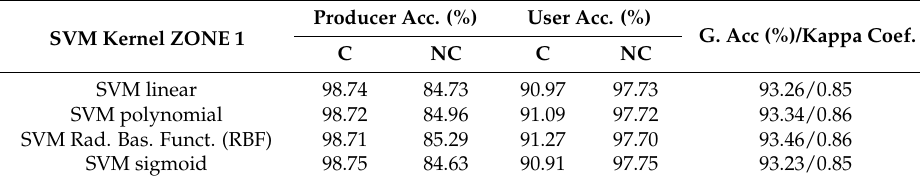
Table 8. DS1. Accuracy analysis of the SVM Fusion